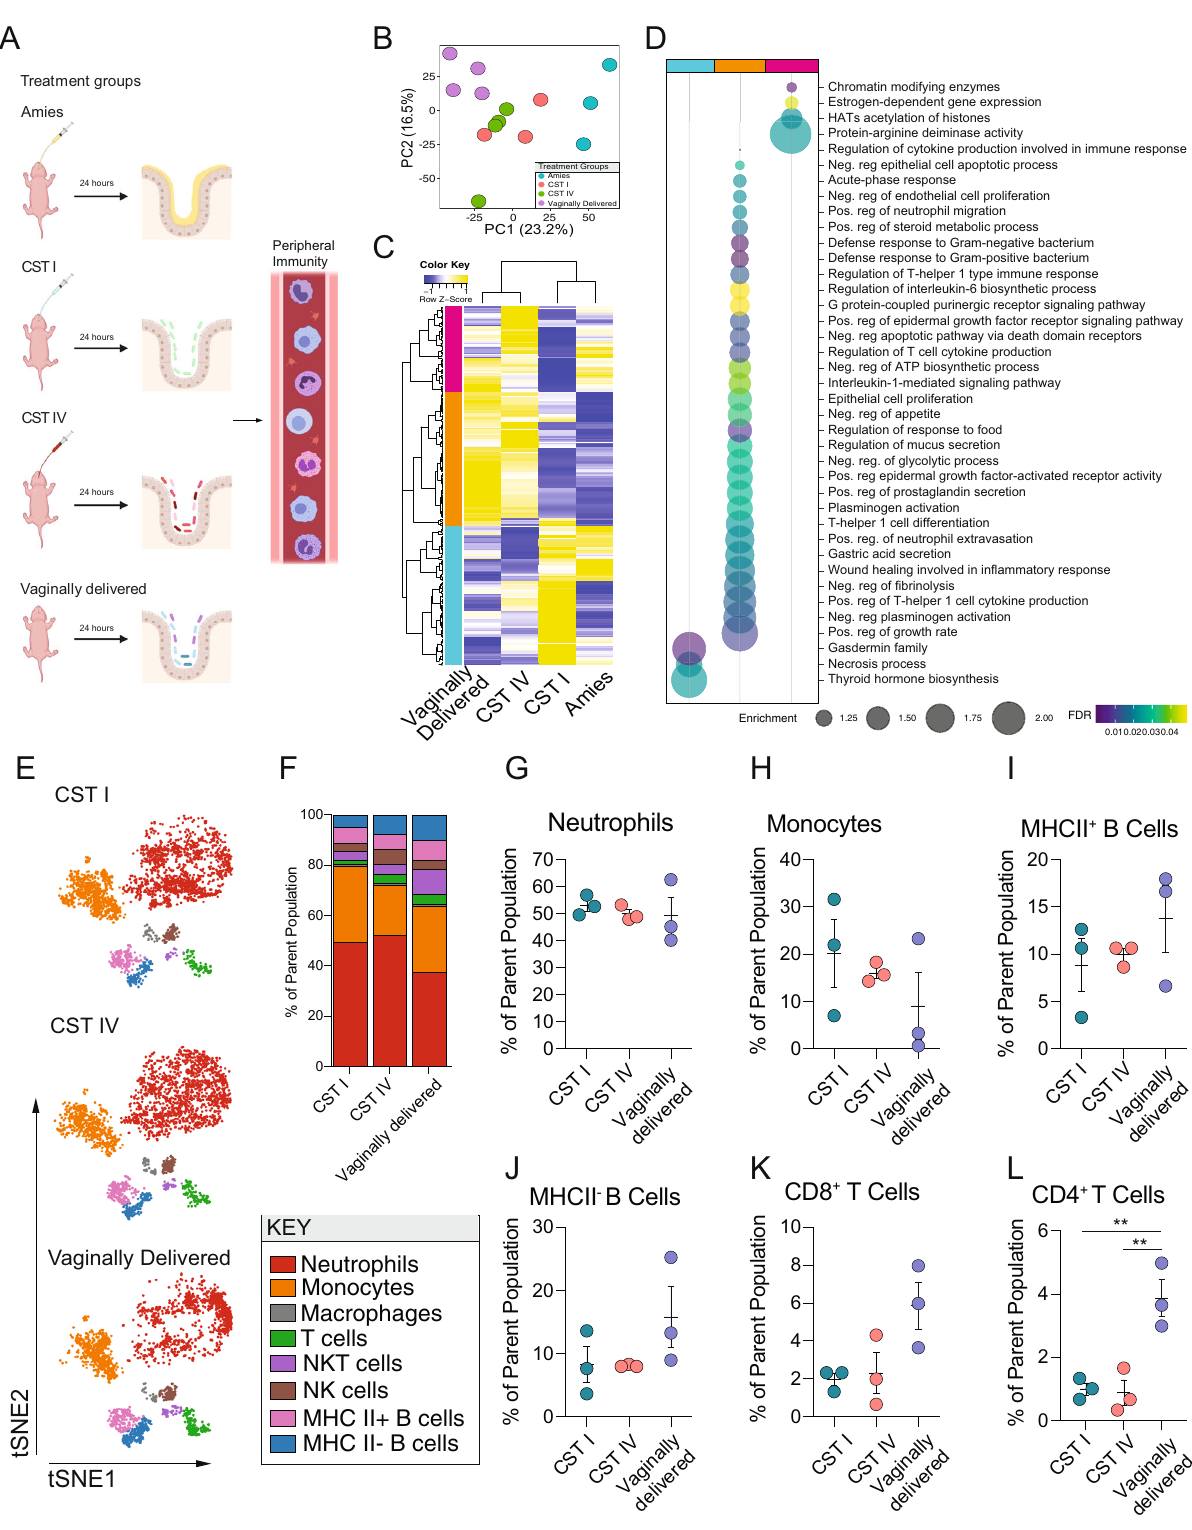
signi fi cant alterations to microbiota structure and composition in in HFt-LFb compared with LFt-HFb pregnant dams (Supplemen- HFt-LFb dams compared with LFt-HFb dams across pregnancy tary Fig. 9d, e) 73,74 . Following con fi rmation of the impact of the single-hit dietary (Supplementary Fig. 9b, c). Differential abundance analysis revealed exposure on maternal body weight, glucose tolerance, and the gut 36 differentially abundant taxa between HFt-LFb and LFt-HFb, microbiota, we next examined the effect of a nonoptimal vaginal including the reduced relative abundance of butyrate-producing microbiota on these outcomes. Pregnant HFt-LFb or LFt-HFb Butyricoccus and the immunomodulatory Candidatus Arthromitus NATURE COMMUNICATIONS| (2021) 12:6289